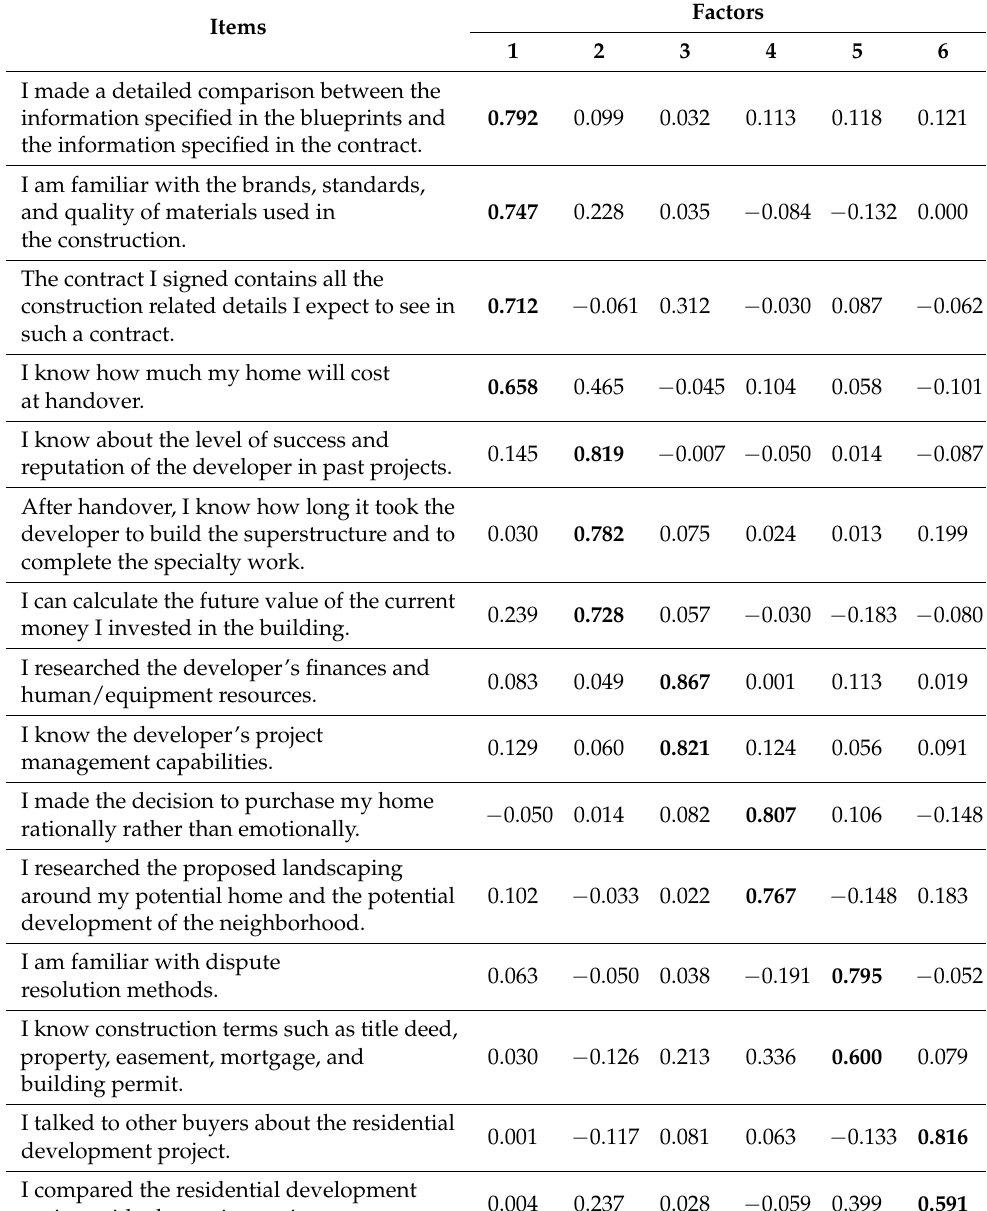
Table 7. Factor pattern of the knowledge construct.